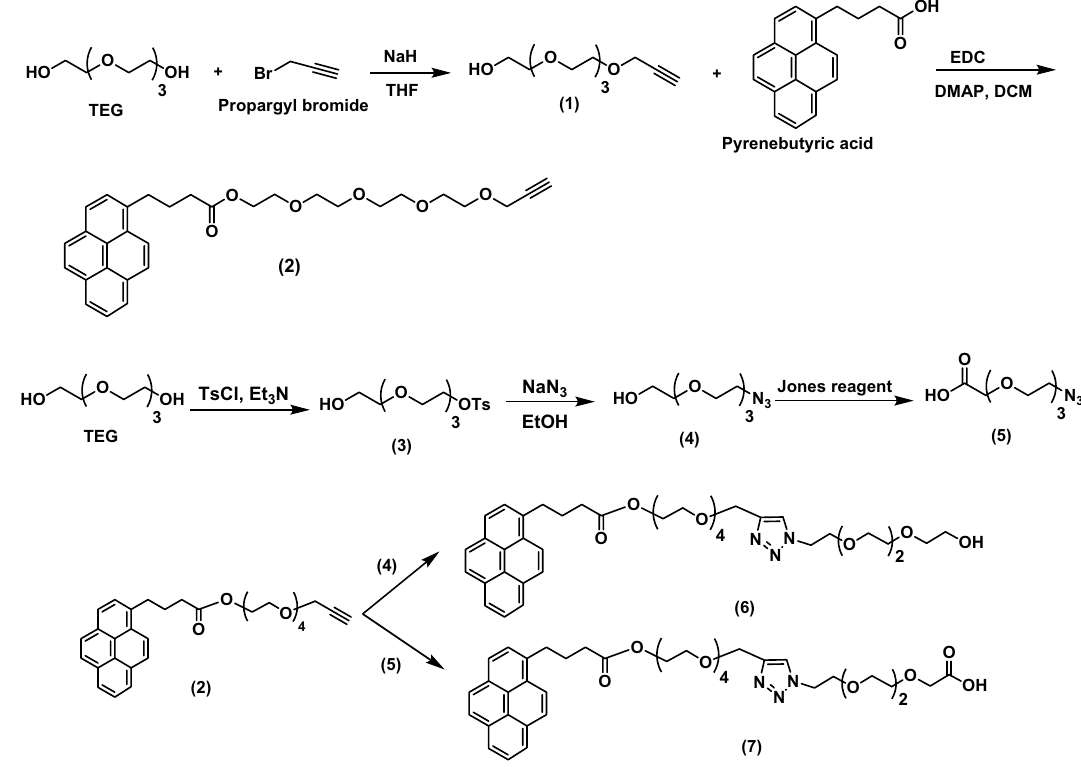
Figure 3. Synthesis of Py-TEG-triazole-TEG-OH (6) and Py-TEG-triazole-TEG-COOH (7).